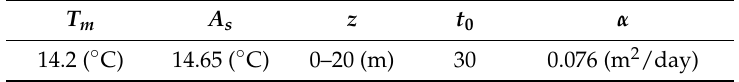
Table 3. Coefficients used in the calculation of the ground temperature distribution.